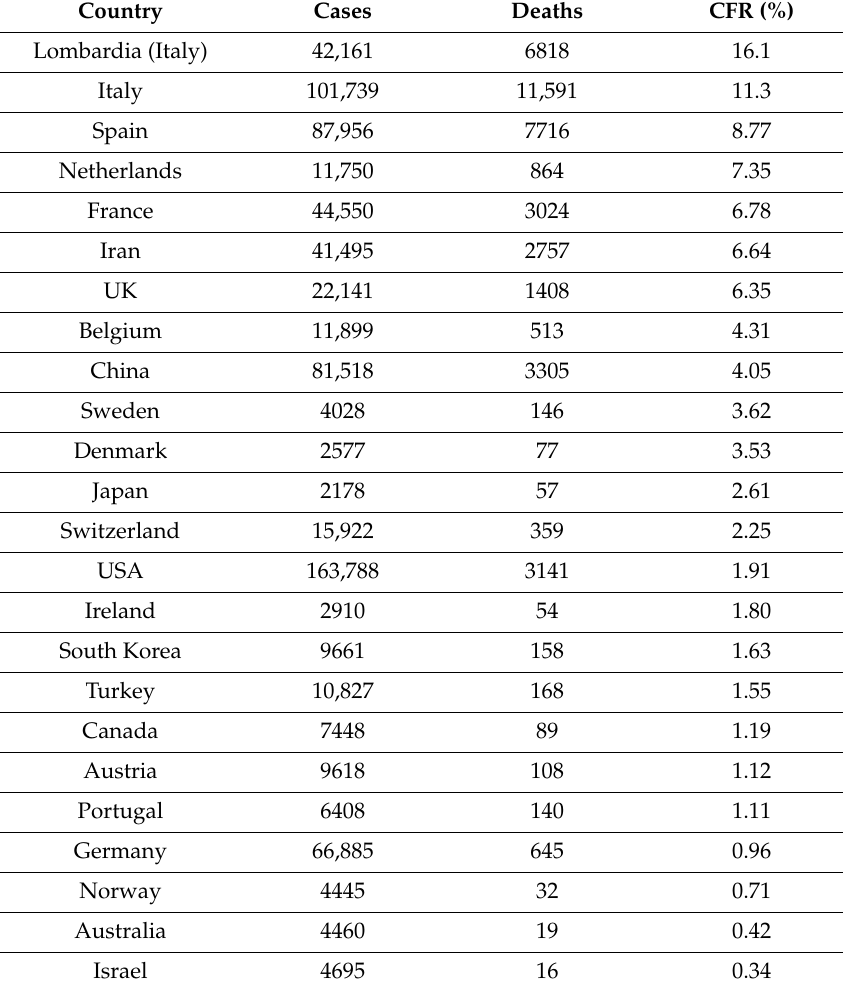
Table 1. Numbers of recorded infections and deaths in several countries as of 30 March 2020. Also indicated is the CFR (case fatality ratio) defined as the ratio between the number of deaths and the number of recorded